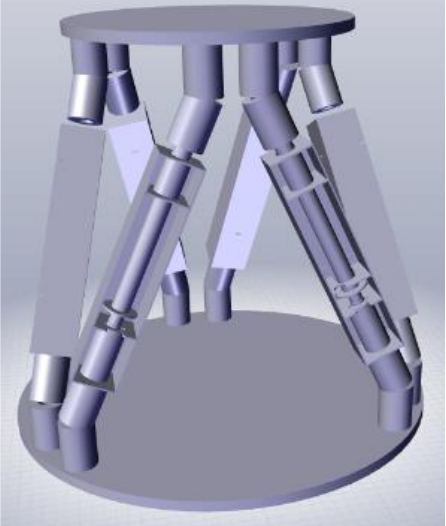
Figure 5. Mechanical structure design of the six degree of freedom parallel platform.